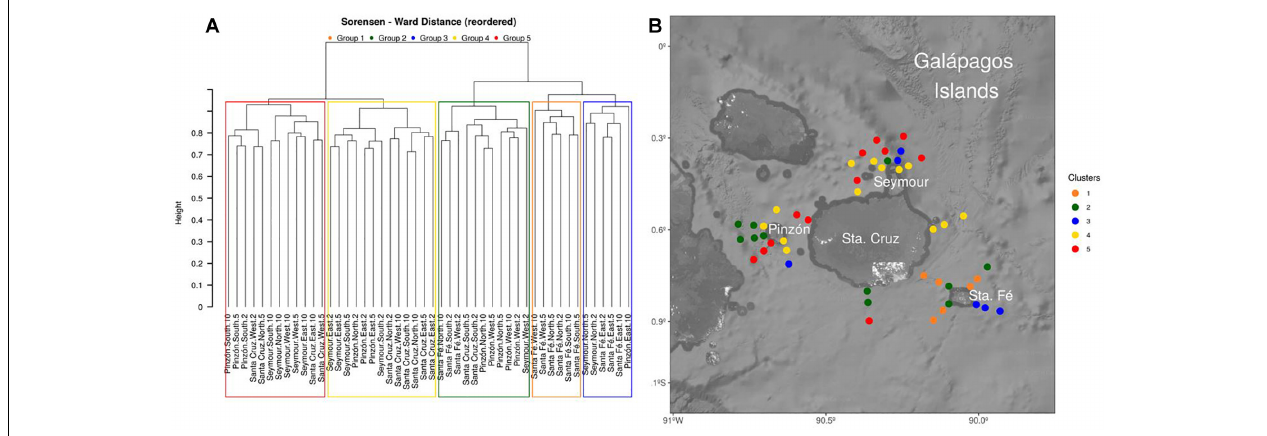
FIGURE 3 | (A) Hierarchical clustering of stations showing the final dendrogram with the five discrete groups and (B) spatial (horizontal) distribution of the five discrete dinoflagellates assemblages (clusters) found in the area of study.